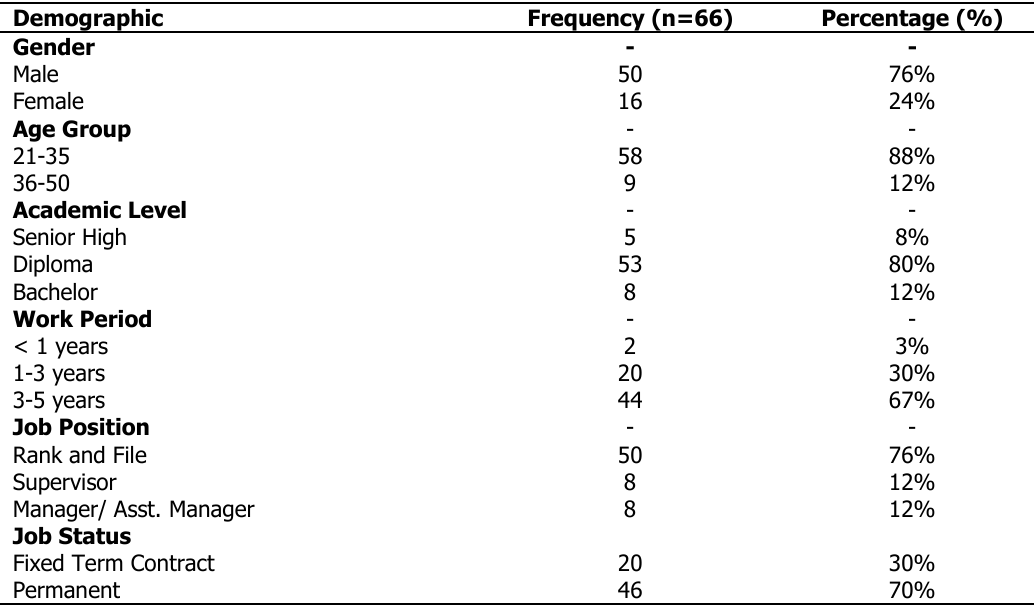
Table 1. Demographic Information of Survey